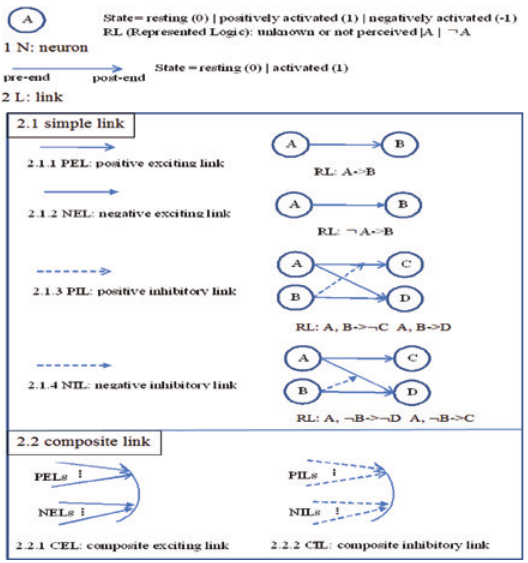
Figure 3: Basic Components of PLDNN to Represent Logical